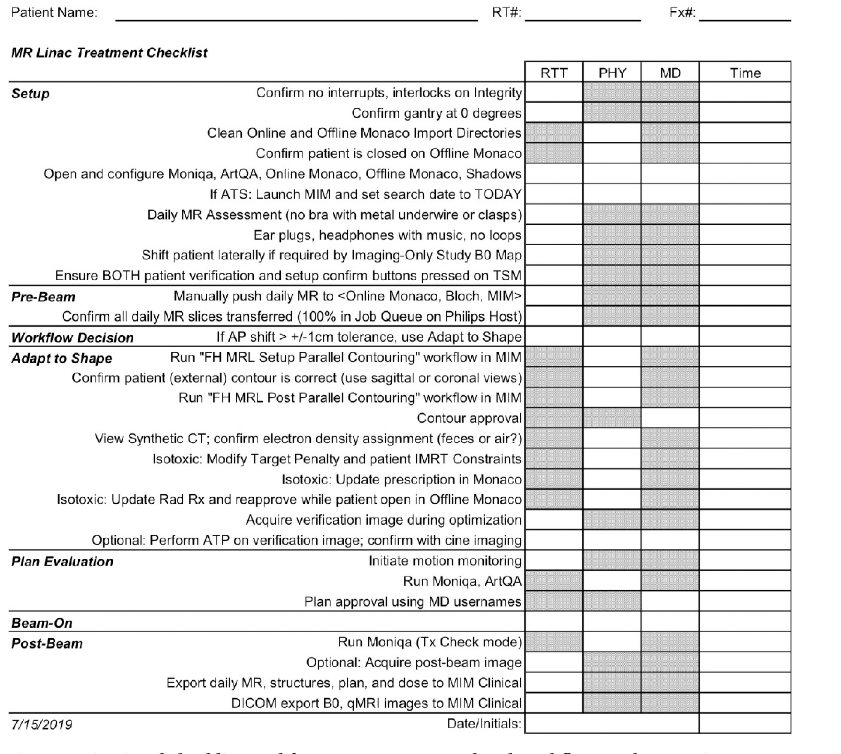
Fig 1. Institutional checklist used for treatment approval and workflow on the MR